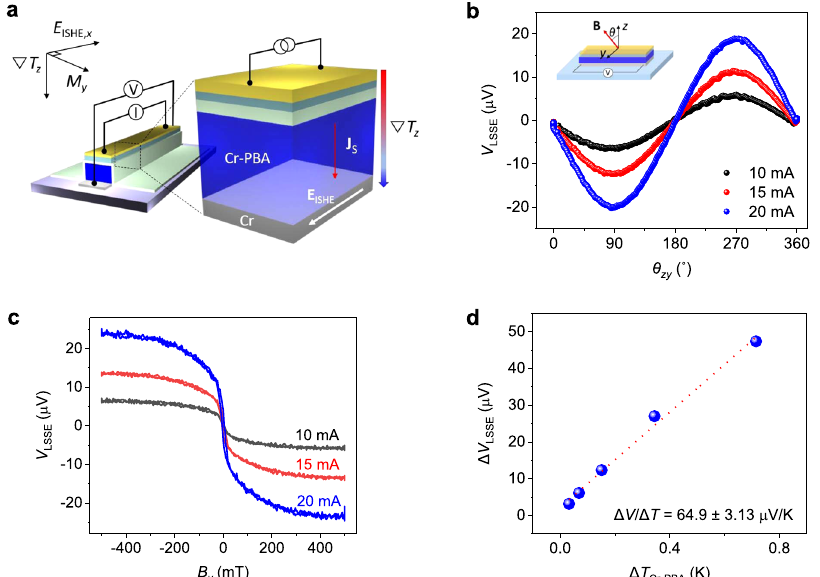
Fig. 2 LSSE characterization for Cr-PBA/Cr heterojunction devices. a A schematic illustration for the LSSE characterization of the Cr-PBA/Cr STE device. The temperature gradient was applied by Joule heating of a top Au line. The vertical fl ow of magnons pumps a pure spin current to the adjacent Cr layer. Then, the induced spin fl ow is converted into a longitudinal charge current producing electric fi eld of E ISHE . b V LSSE as a function of zy angle of the applied magnetic fi eld (1 T) measured with different heating currents I heater = 10, 15, and 20 mA at 100 K. Measurements were done for the Cr-PBA (1.4 μ m)/Cr (10 nm) STE device. c V LSSE upon sweeping the applied magnetic fi eld measured with different heating currents I heater = 10, 15, and 20 mA at 100 K. d Δ V LSSE as a function of the estimated Δ T in a Cr-PBA fi lm displaying a linear behavior. The obtained value of the slope is Δ V LSSE / Δ T ~ 64.9 ± 3.13 μ V/K at 100 K.